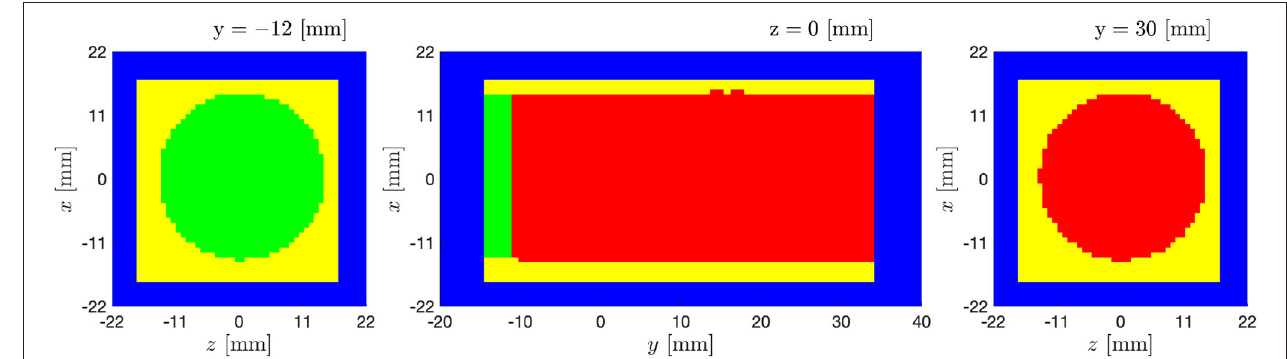
FIGURE 12 | Pulsatile turbulent flow downstream of a transcatheter aortic valve: Numerical setup. The experimental grid is overlapped onto the computational domain (blue). The wall boundary conditions are imposed in the yellow region which includes data masked in the experiments; The inflow boundary conditions are imposed in the green region; DA is performed in the red